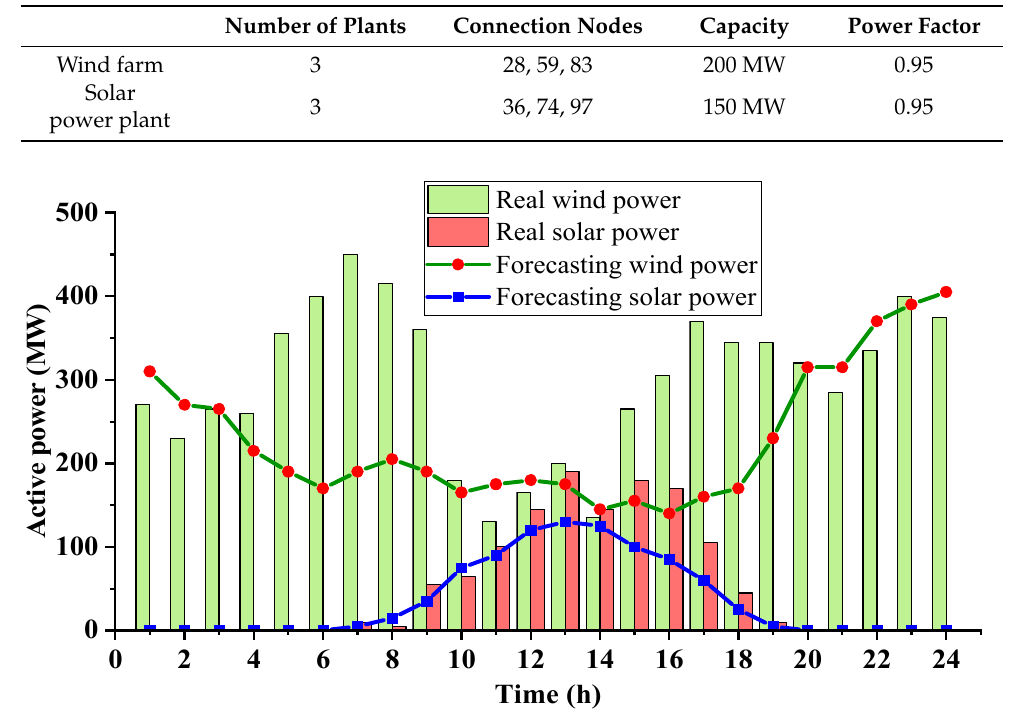
Figure 1. Output of wind and solar power.